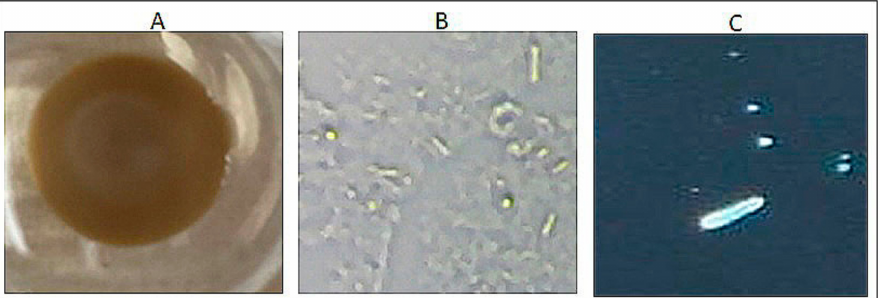
Figure 3. Analysis of turbid synovial fluid for detection of urate crystals. Representative image. ( A ) iPhone image; ( B ) Plugable Microscope image; ( C ) Accuscope Microscope